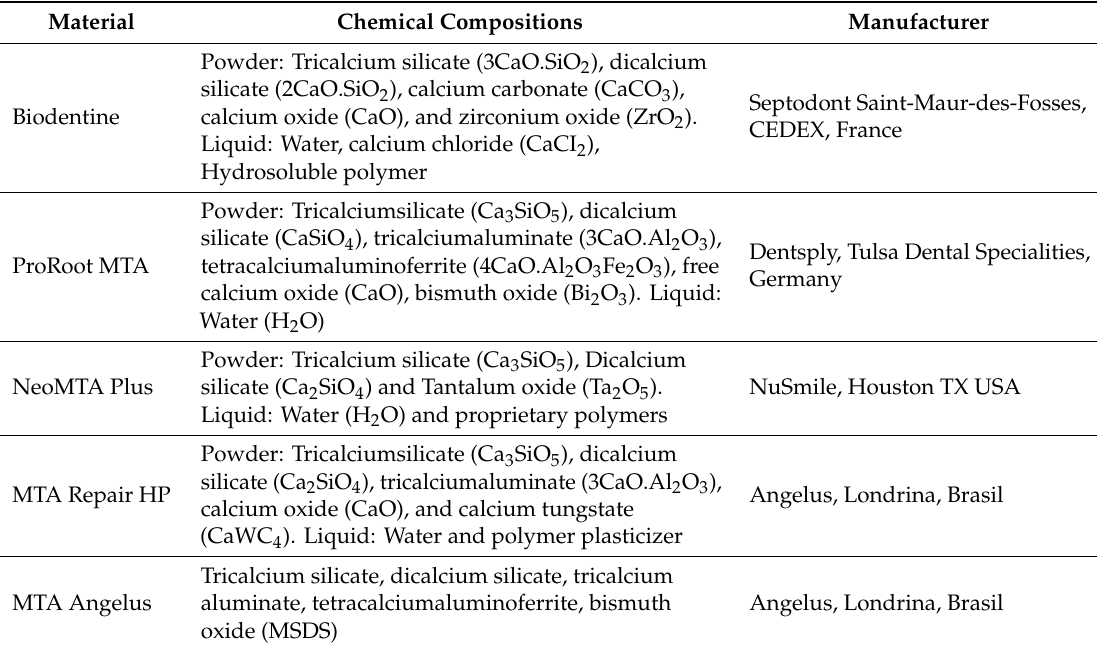
Table 1. Chemical compositions of tested